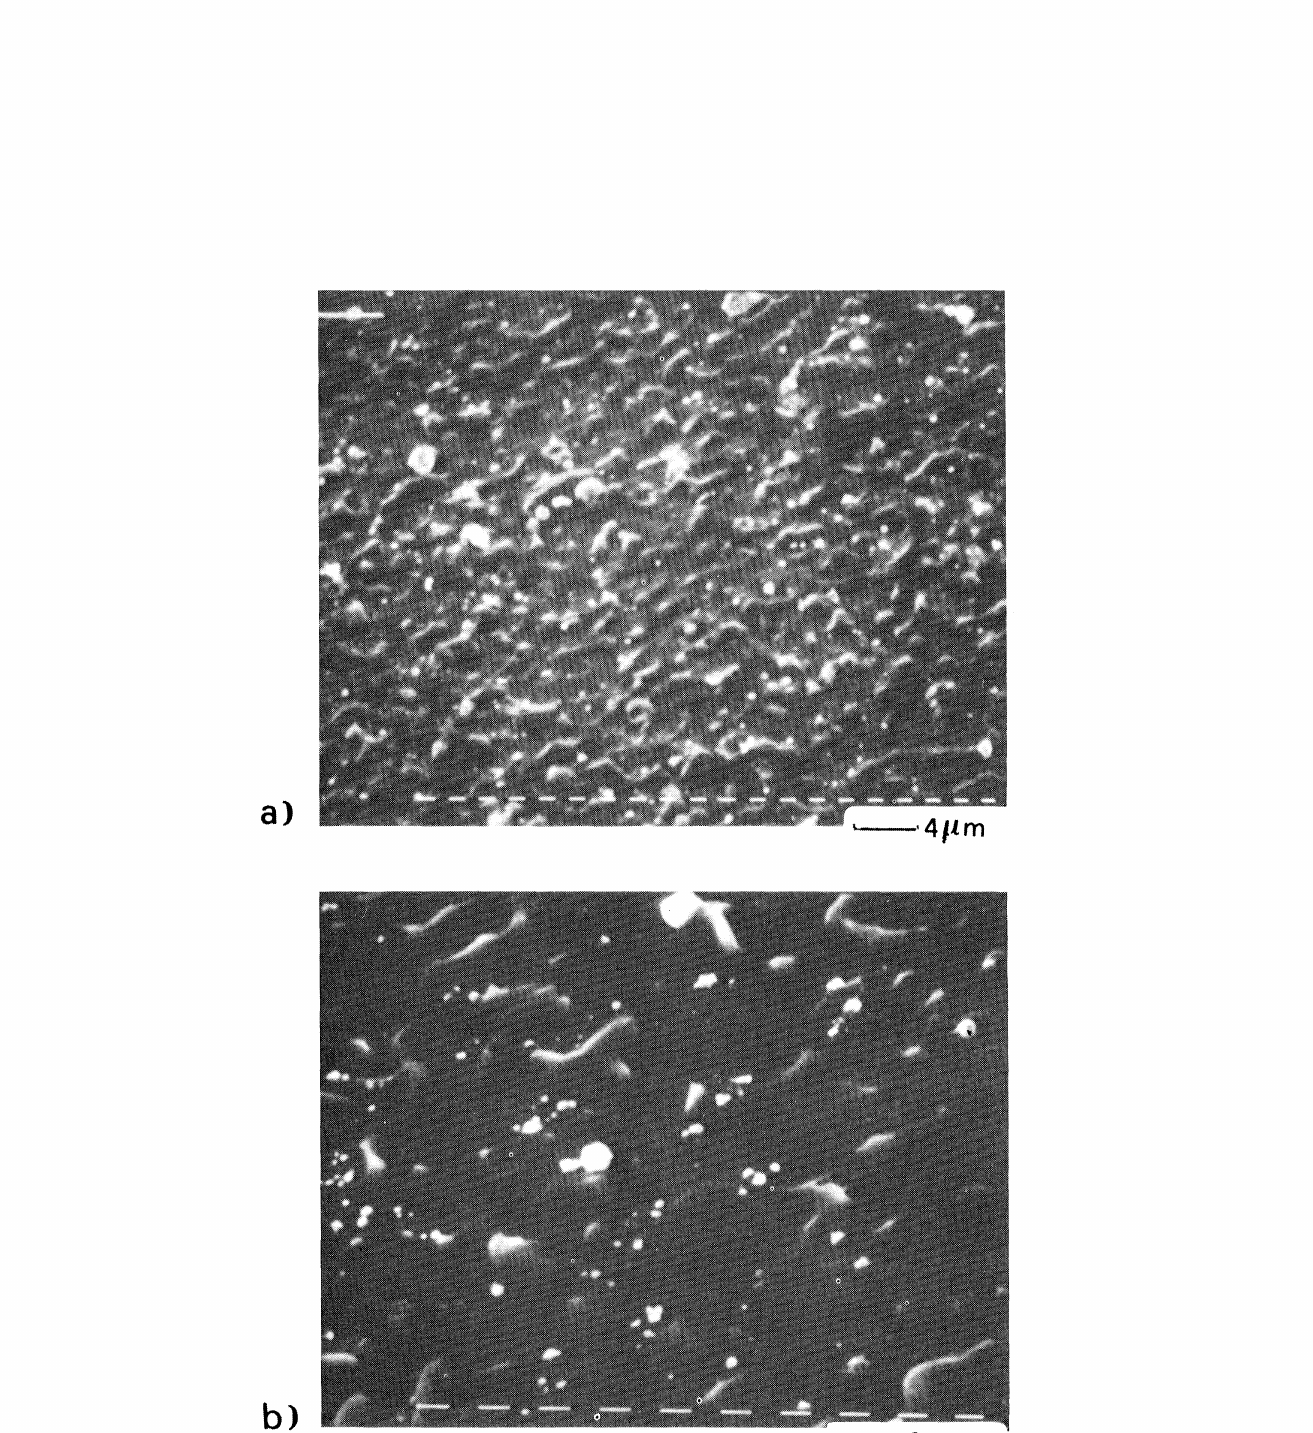
FIGURE 7 Surface of the silicon cell under a bus bar, after the removal of the front contact by means of chemical etching, a) 2500 X, b) 5000